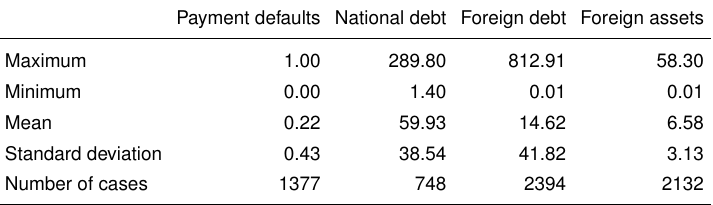
Table 3. Descriptive statistics.